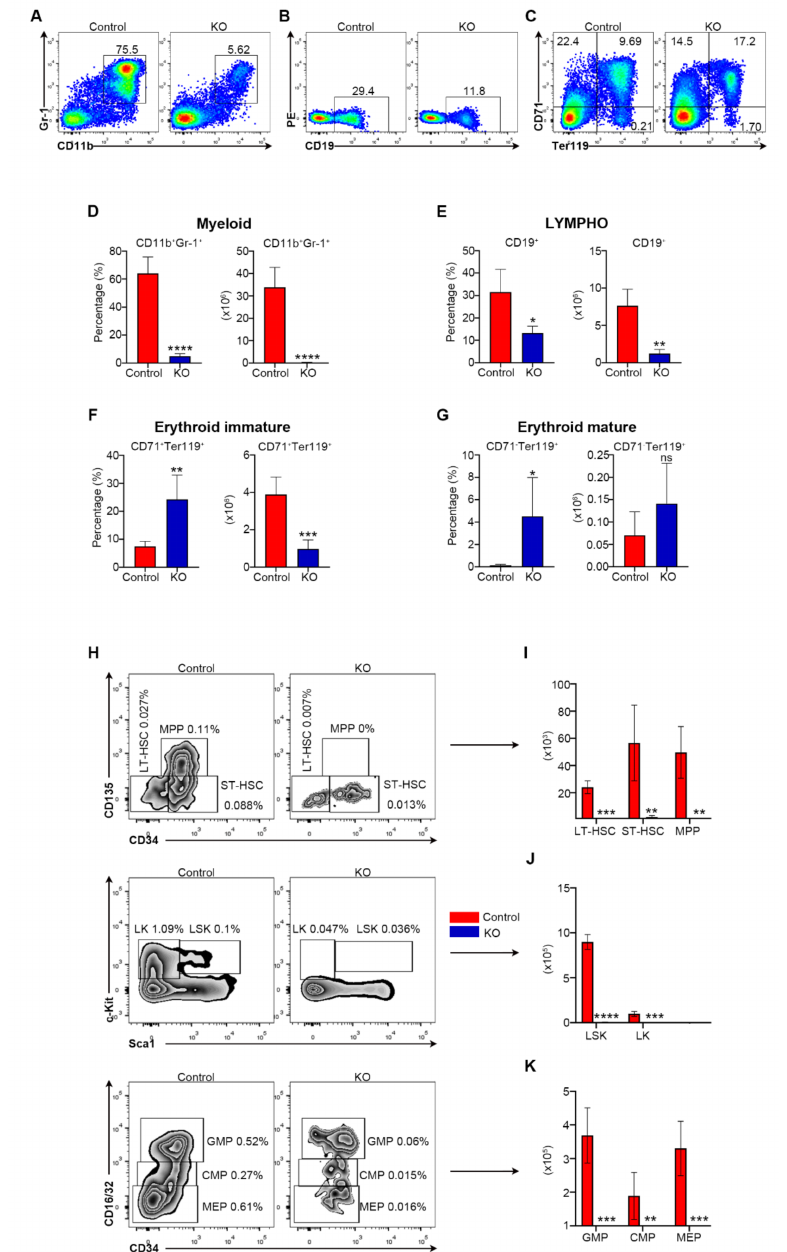
Figure 2. Myh9 deficiency causes deletion of multiple hematopoietic lineages and HSC. Represen- tative dot plots ( A – C ), frequencies (left), and total numbers (right) of Gr-1 + CD11b + myeloid ( D ), CD19 + B ( E ), CD71 + Ter119 - immature erythroid cells ( F ), and CD71 - Ter119 + mature erythroid cells ( G ) (n = 4–5). ( H ) Representative contour plots of flow cytometric analysis of LK(Lin - sca1 - c-kit + ), LSK (Lin - sca1 + c-kit + ), LT-HSC (Lin - sca1 + c-kit + CD34 - CD135 - ), ST-HSC (Lin - sca1 + c-kit + CD34 + CD135 - ), MPP (Lin - sca1 + c-kit + CD34 + CD135 + ), GMP (Lin - sca1 - c-kit + CD34 + CD16/32 high ), CMP (Lin - sca1 - c- kit + CD34 + CD16/32 low ), MEP (Lin - sca1 - c-kit + CD34 - CD16/32 - ). Total numbers of LT-HSC, ST-HSC and MPP ( I ); LK and LSK ( J ); GMP, CMP and MEP ( K ) in the BM of control and Myh9 fl/fl :Mx1-cre mice 10 days after first poly I:C injection (n = 4). All data are shown as mean ± SD . Student t test was used to compare two groups of mice (* p < 0.05,** p < 0.005,*** p < 0.001,**** p <